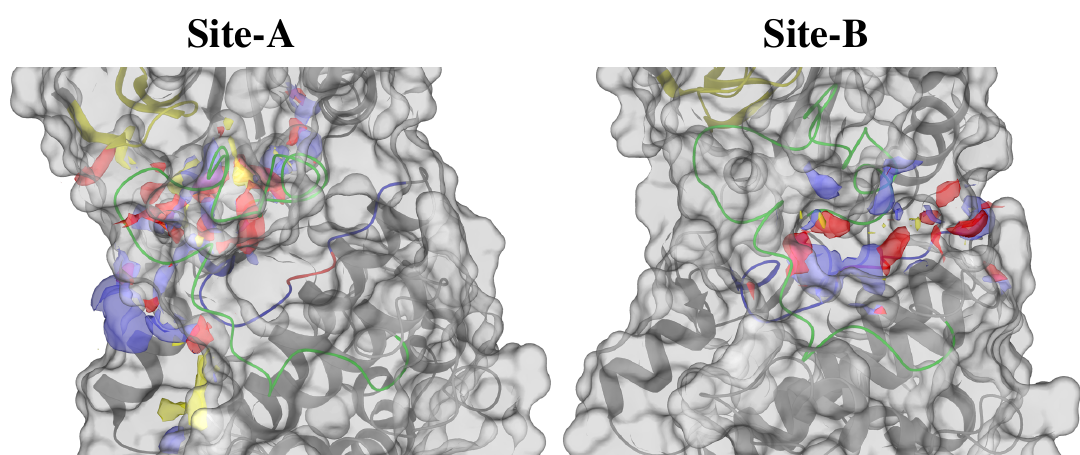
Figure 6. LmJean3 displays two promising binding sites for small-molecule, drug-like ligands. Hydrophobic (yellow), donor (blue), and acceptor (red) maps for ( A ) the ATP-binding pocket and the adjacent allosteric site and ( B ) the protein substrate binding site. SiteMap version 3.8 [82,83] was used to identify the binding sites, and Maestro Schrödinger Release 2017-2 to compose the